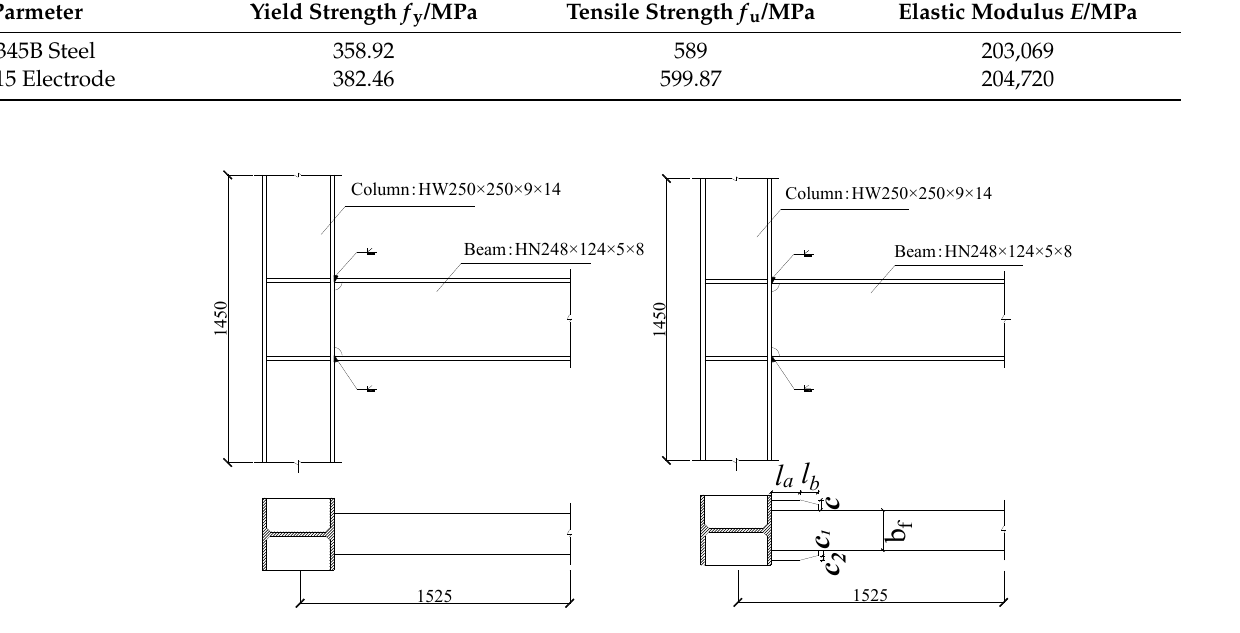
Figure 1. Dimensions and details of specimens. Unit: mm. Table 1. Q345B steel and E5015 electrode material test results .